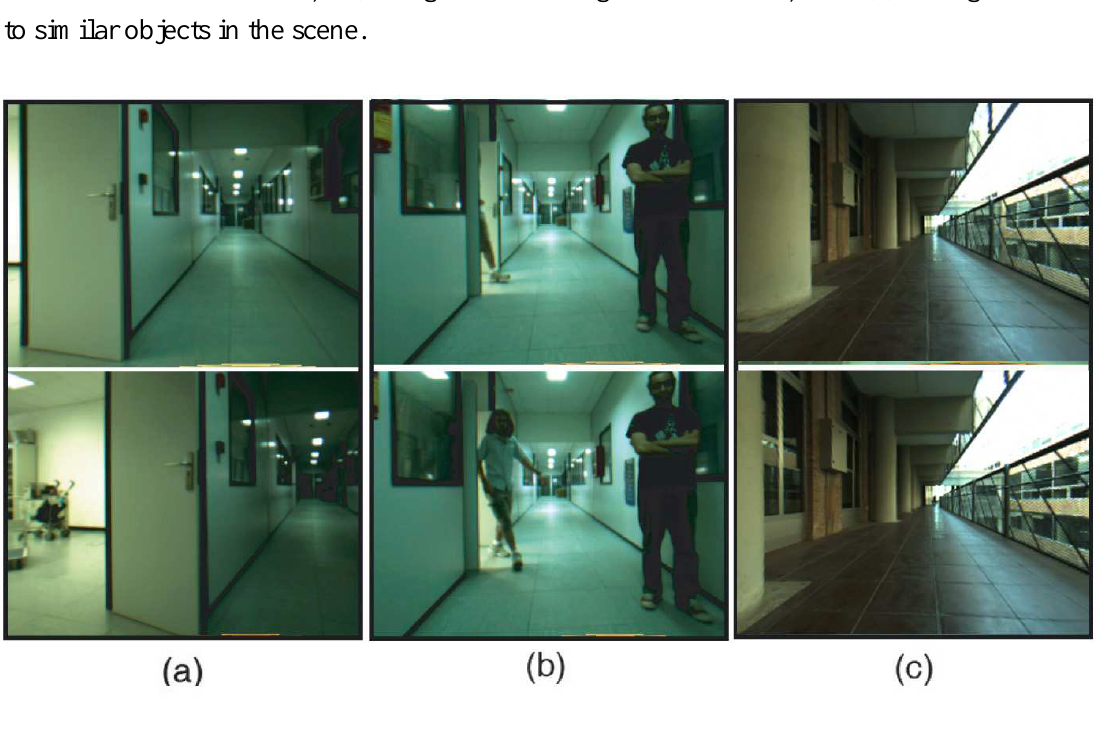
Figure 7. A set of 320 × 240 images acquired by the camera has been used to evaluate the robustness and time processing of the matching algorithm. (a) a camera movement (translation and rotation); (b) a significant change in the scene; and (c) ambiguities due to similar objects in the